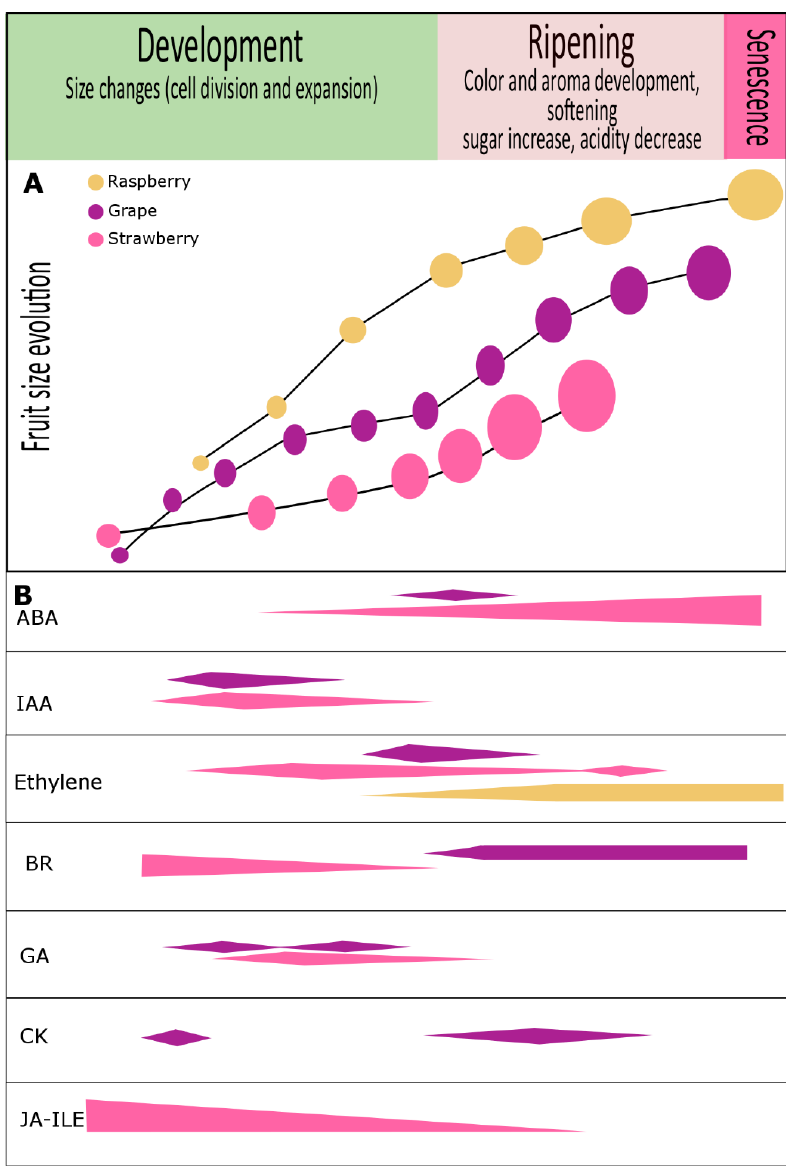
Figure 1. Phytohormone content evolution during development and ripening of grape, strawberry and raspberry fruits. ( A ) Developmental trends according to fruit size in grape (purple) [203], strawberry (pink) [18,51] and raspberry (yellow ochre) [53]. ( B ) Variations in hormone levels are shown for abscisic acid (ABA), auxin (IAA), ethylene, brassinosteroids (BR), gibberellins (GA), cytokinins (CK),